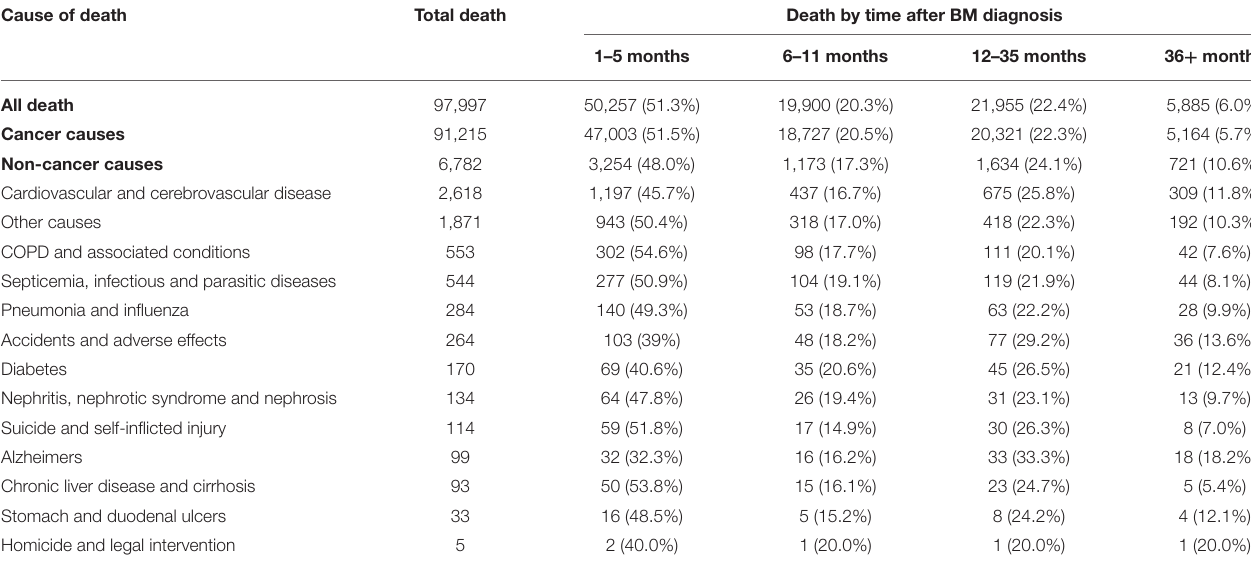
TABLE 3 | Causes of death according to the time of death after initial BM diagnosis.